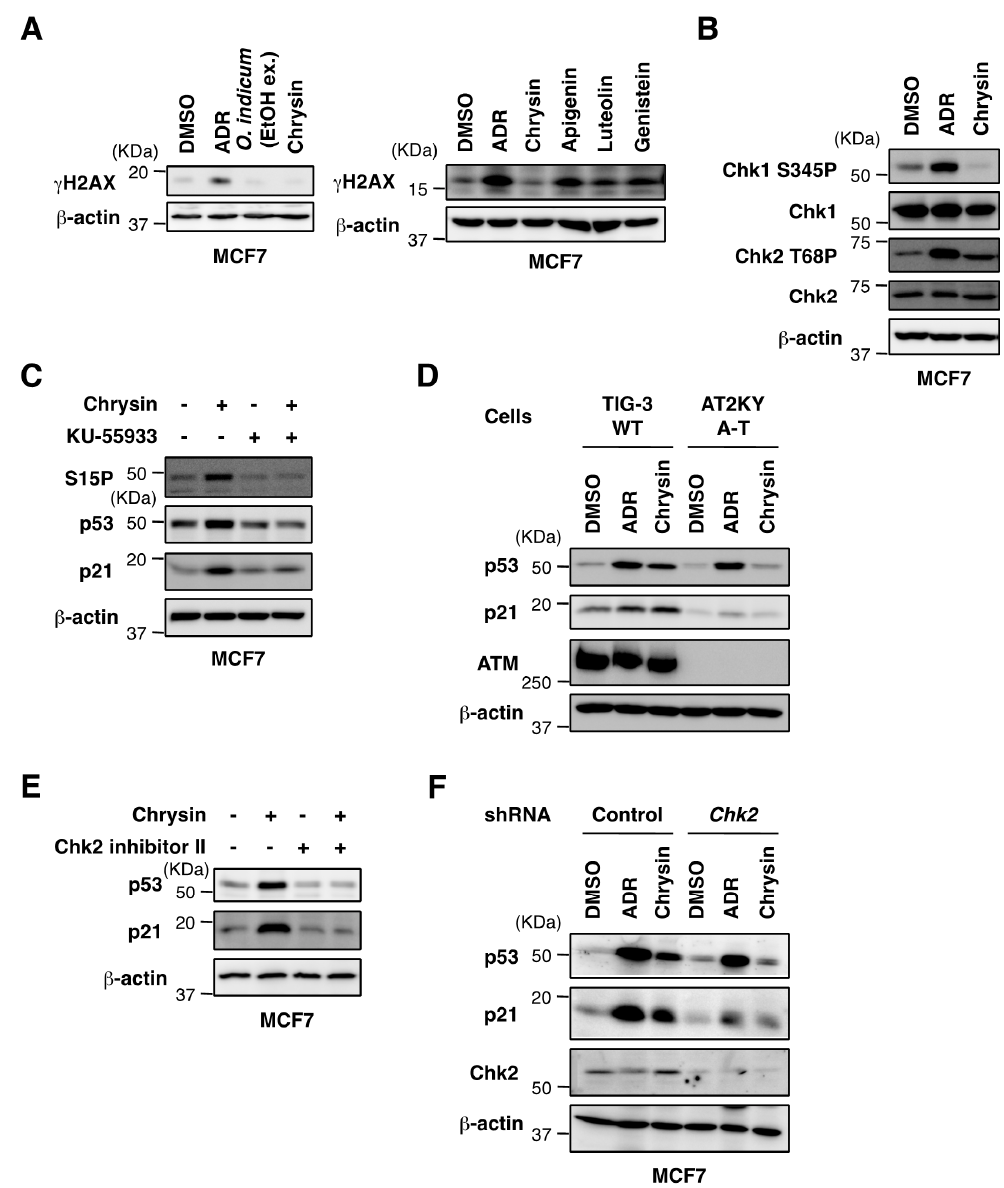
Figure 5. Chrysin activated the ATM-Chk2 pathway in the absence of DNA damage. ( A ) MCF7 cells were treated with ADR (0.3 μ M), the ethanol extract of O. indicum bark (100 μ g/mL), chrysin (40 μ M), or flavonoids (40 μ M) for 8 h. Cell lysates were immunoblotted with the indicated antibodies. ( B ) MCF7 cells were treated with ADR (0.3 μ M) or chrysin (40 μ M) for 8 h. Cell lysates were immunoblotted with the indicated antibodies. ( C ) MCF7 cells were pretreated with KU-55933 (10 μ M) for 1 h and subsequently treated with chrysin (40 μ M) for 8 h. Cell lysates were immunoblotted with the indicated antibodies. ( D ) TIG-3 cells and AT2KY cells were treated with ADR (0.3 μ M) or chrysin (40 μ M) for 8 h. Cell lysates were immunoblotted with the indicated antibodies. ( E ) MCF7 cells were pretreated with Chk2 inhibitor II (10 μ M) for 1 h and subsequently treated with chrysin (40 μ M) for 8 h. Cell lysates were immunoblotted with the indicated antibodies. ( F ) shcontrol-MCF7 and shChk2-MCF7 cells were treated with ADR (0.3 μ M) or chrysin (40 μ M) for 8 h. Cell lysates were immunoblotted with the indicated antibodies.